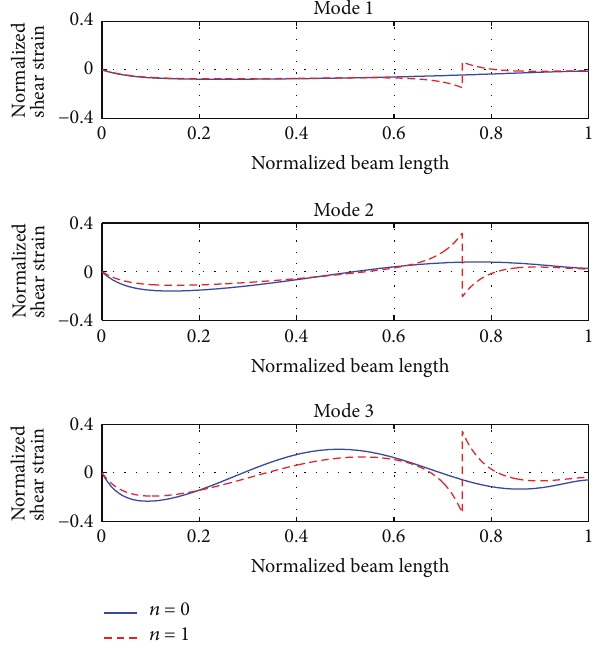
Figure 9: Comparison of the shear strain field between full-cover and segmented CLD beams with ratio 𝐻 𝑏 = 𝐻 𝑐 = 0.001 .